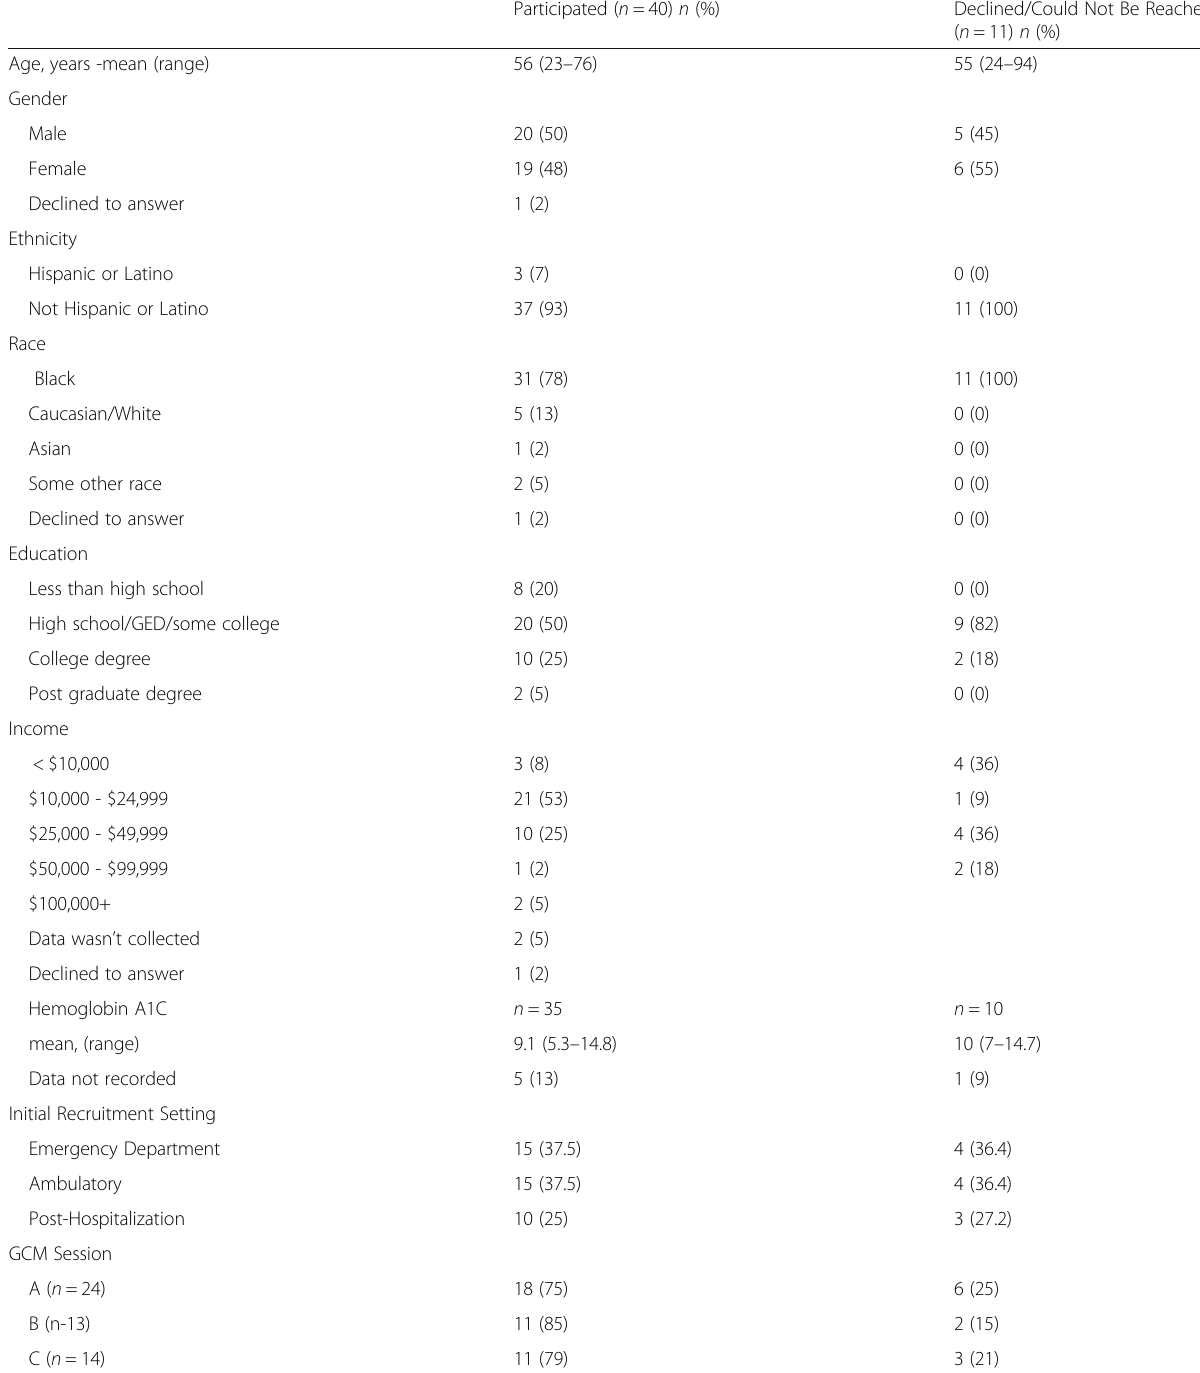
Table 1 Characteristics of the Survey Respondents and